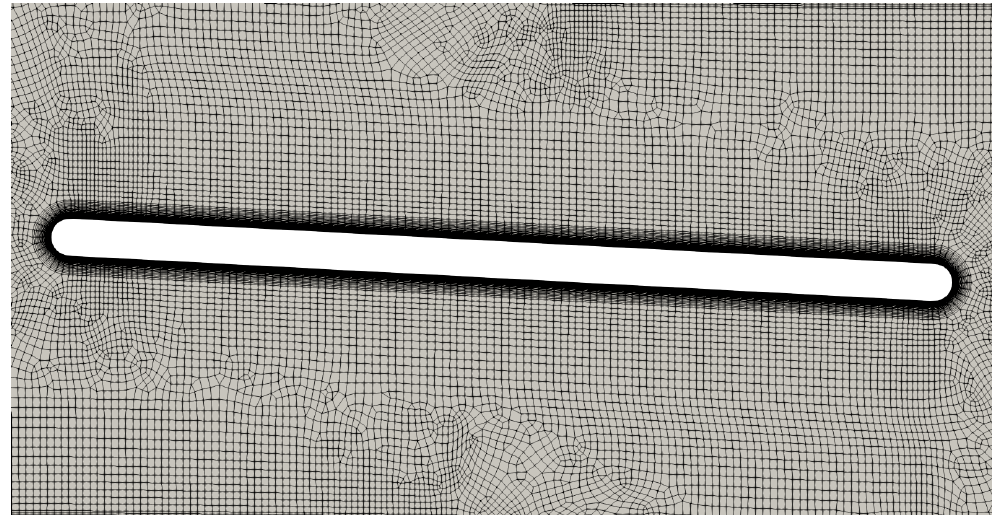
Figure 3. Detail of the coarse mesh in the vicinity of the middle blade. The distribution of the pressure along the middle blade (blade no. 3) at α = 3° is shown in Figure 4. Differences in the pressure distribution can only be seen in a very small region close to the leading edge, where the medium and fine mesh capture a small separation bubble at the lower side; see Figure